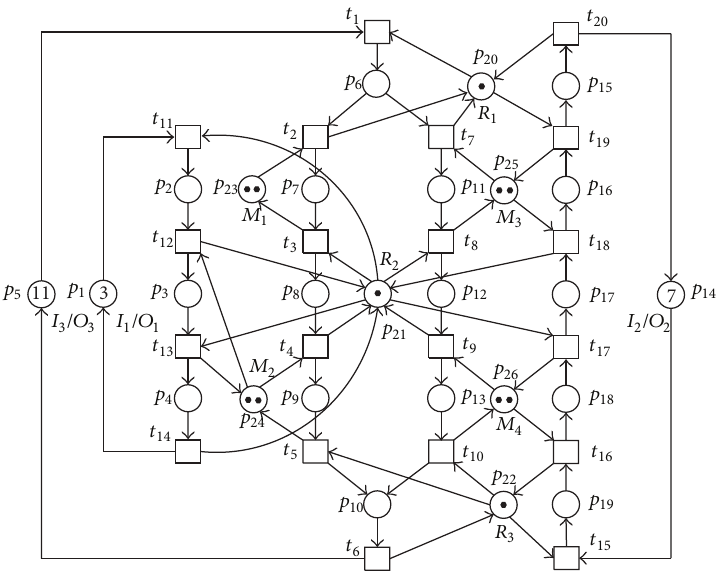
Figure 5: The Petri net model of an FMS.